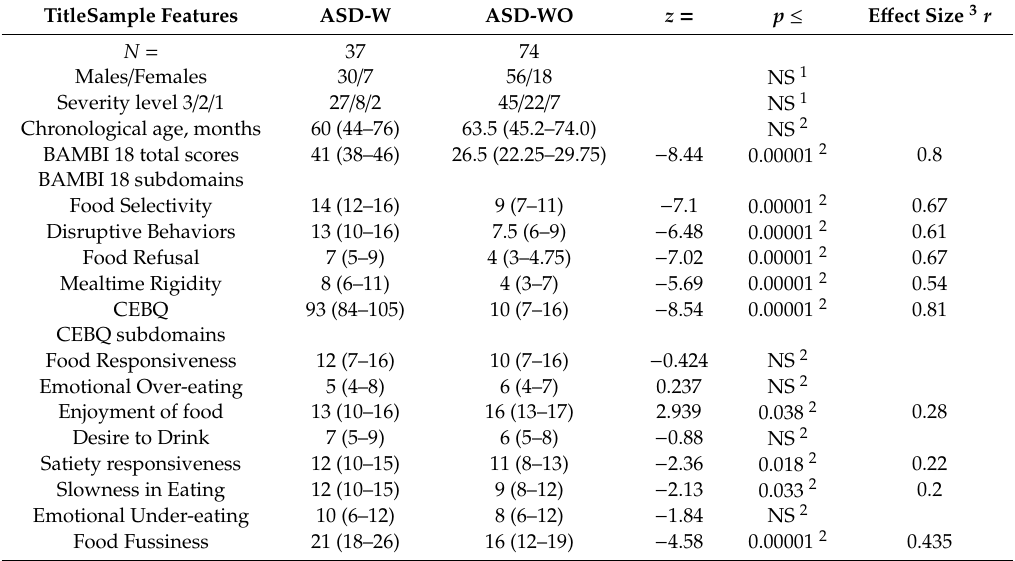
Table 1. Characteristics of the sample and scores obtained at BAMBI 18 and CEBQ, expressed as medians and interquartile